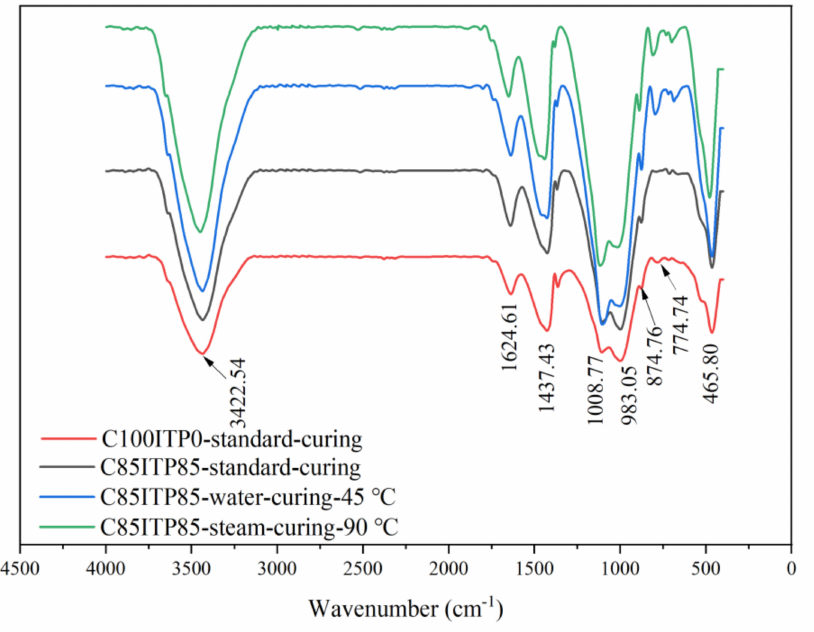
Figure 6. FTIR curves of C100ITP0 under standard curing and C85ITP15 under different curing pro-